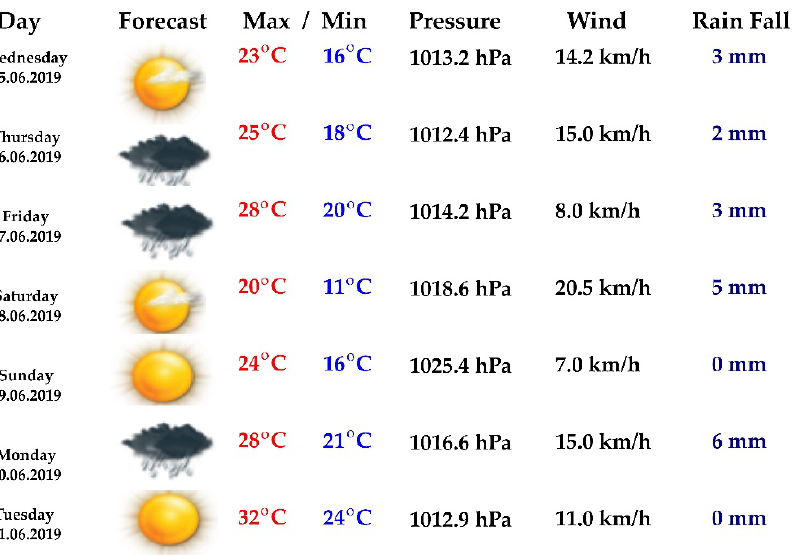
Figure 3. Weather conditions during 7 days of measurement.